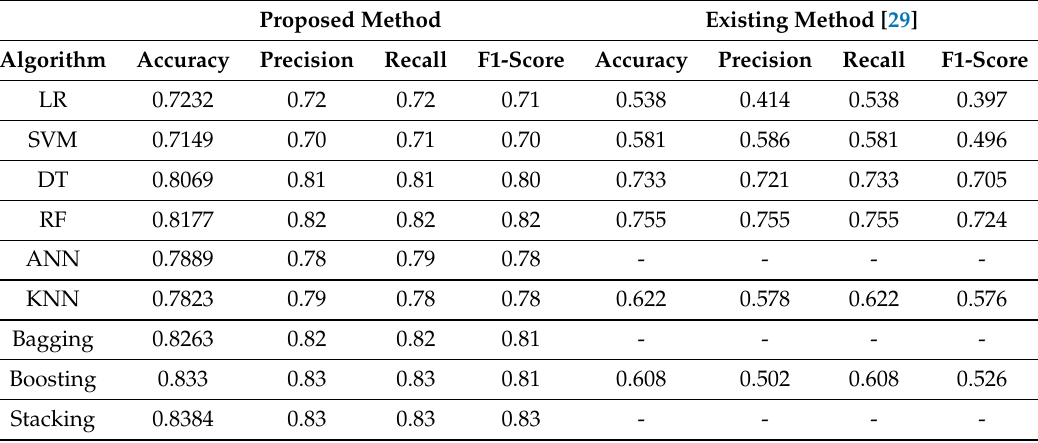
Figure 4. ROC Curve of: ( a ) LR ; ( b ) SVM; ( c ) DT; ( d ) RF; ( e ) ANN; ( f ) KNN, ( g ) Bagging; ( h ) Boosting; and ( i ) Stacking. Table 7. Comparison of multi-class classification performance on